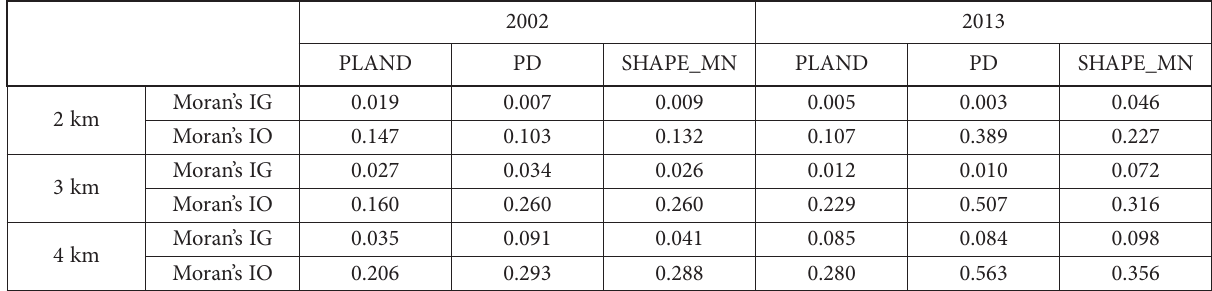
Table 10. Comparison of Moran’s I of the residuals from GWR and